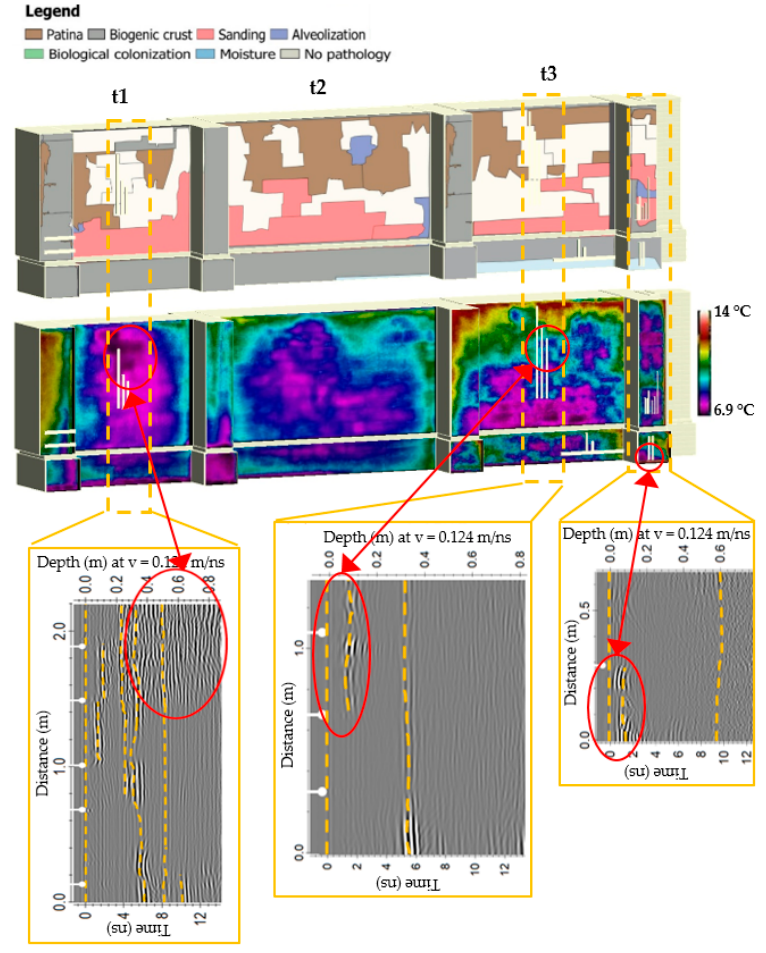
Figure 18. Analysis of the combined representation of the OBIA classification (UAS imaging), IRT and GPR results: the areas highlighted with red circles can be interpreted as “anomalies”.